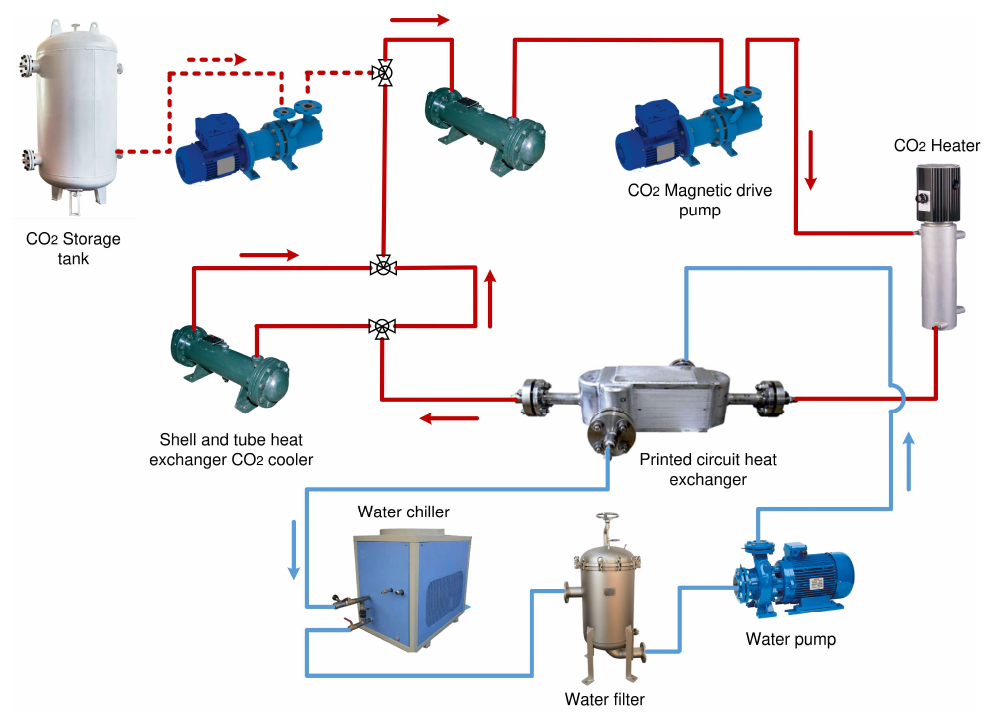
Figure 5. Scheme of operation of the PCHE equipment. Table 4. Technical data of Printed Circuit Heat Exchanger.